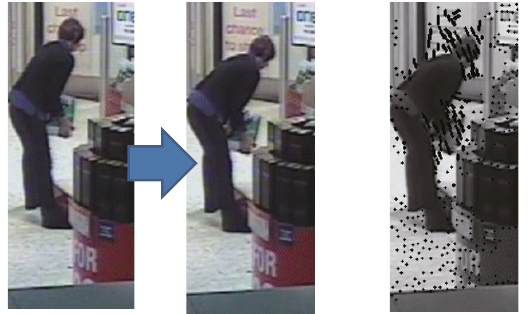
Figure 20: Optical flow in ObjectPut sequence.